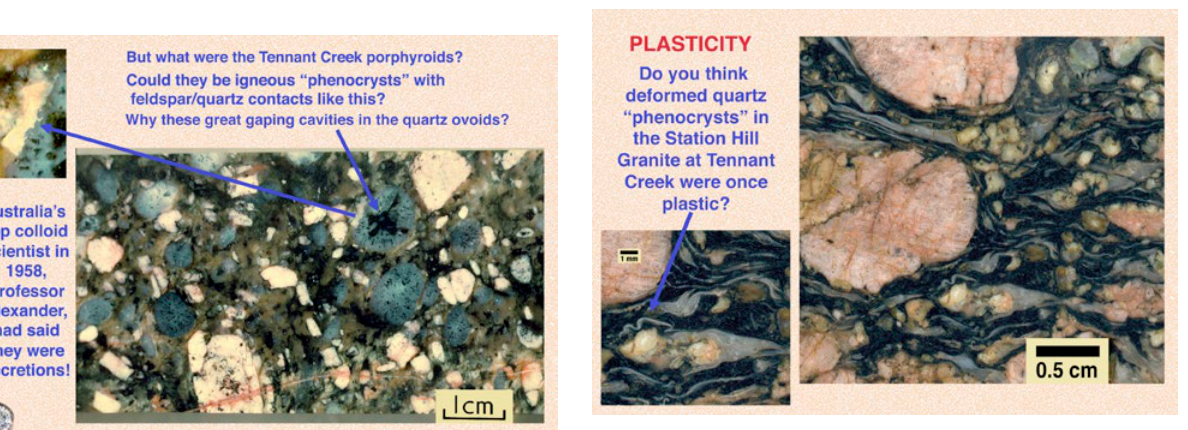
Figure 20. Most geologists recognise that this wispy crystalline quartz in the Station Hill granite at Tennant Creek, Central Aus- tralia, was plastic when the granite was fluid. The former plasticity clearly indicates the quartz crystallised from a polymeric silica pre-